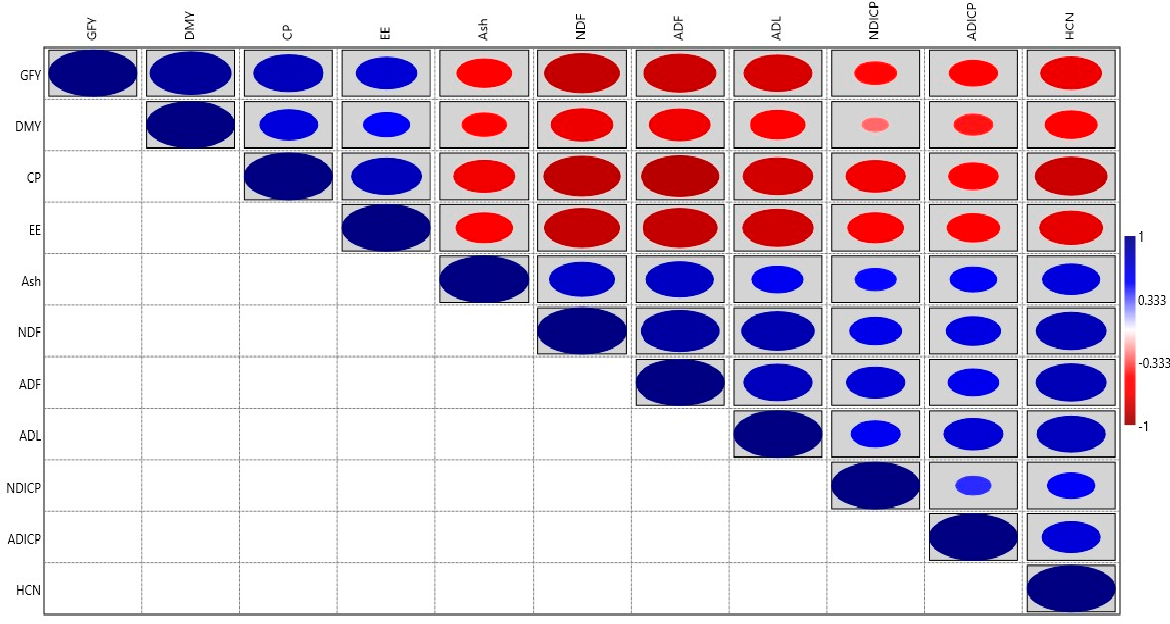
Figure 2. Relationship among green fodder yield (GFY), physiological and biochemical a tt ributes of sorghum crop at 60 DAS; [boxed diagonal shows signi fi cant ( p ≤ 0.05) association; red and blue colour indicate negative and positive correlations, respectively]. RWC: relative water content; MII: membrane injury index; TCC: total chlorophyll content; TSC: total soluble carbohydrate; TSP: total soluble protein content; Fv/Fm: chlorophyll fluorescence; gS: stomatal conductance; E: transpiration rate; Y (II): photon quantum yield; Pn: photosynthetic rate; K/Na: potassium to sodium ratio.